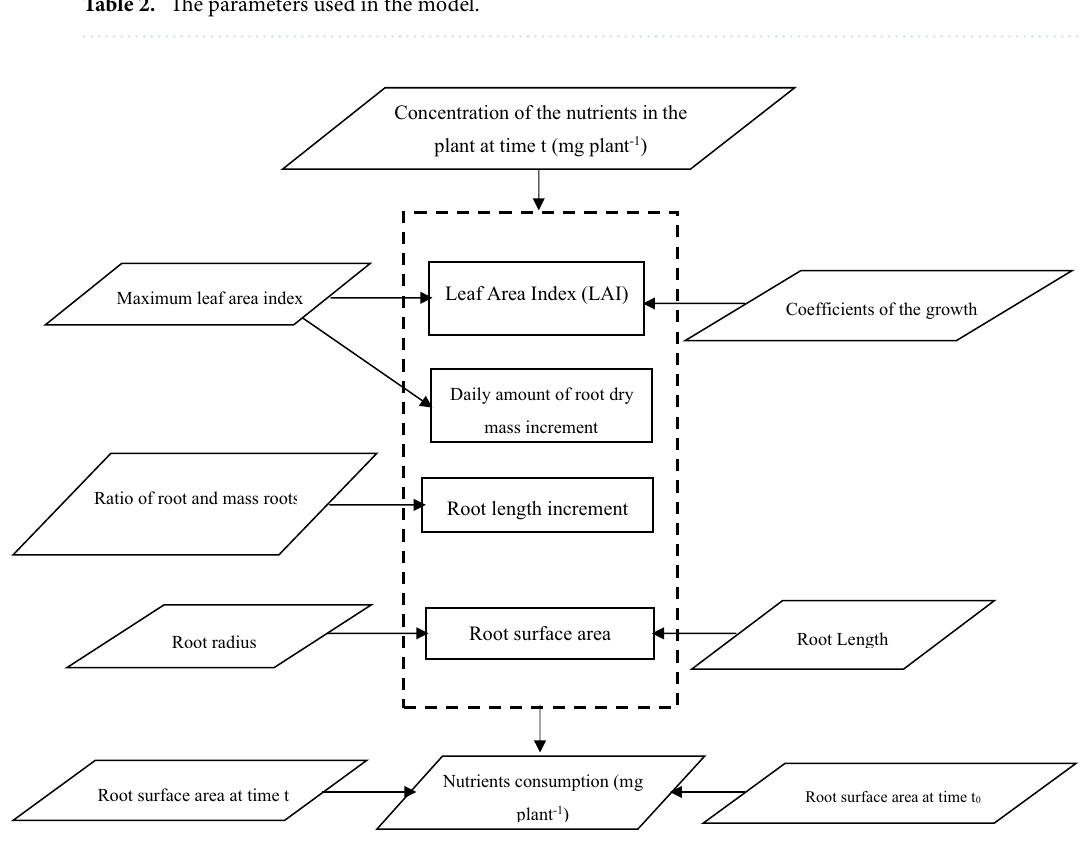
Figure 2. Flow chart of nutrients consumption rate.